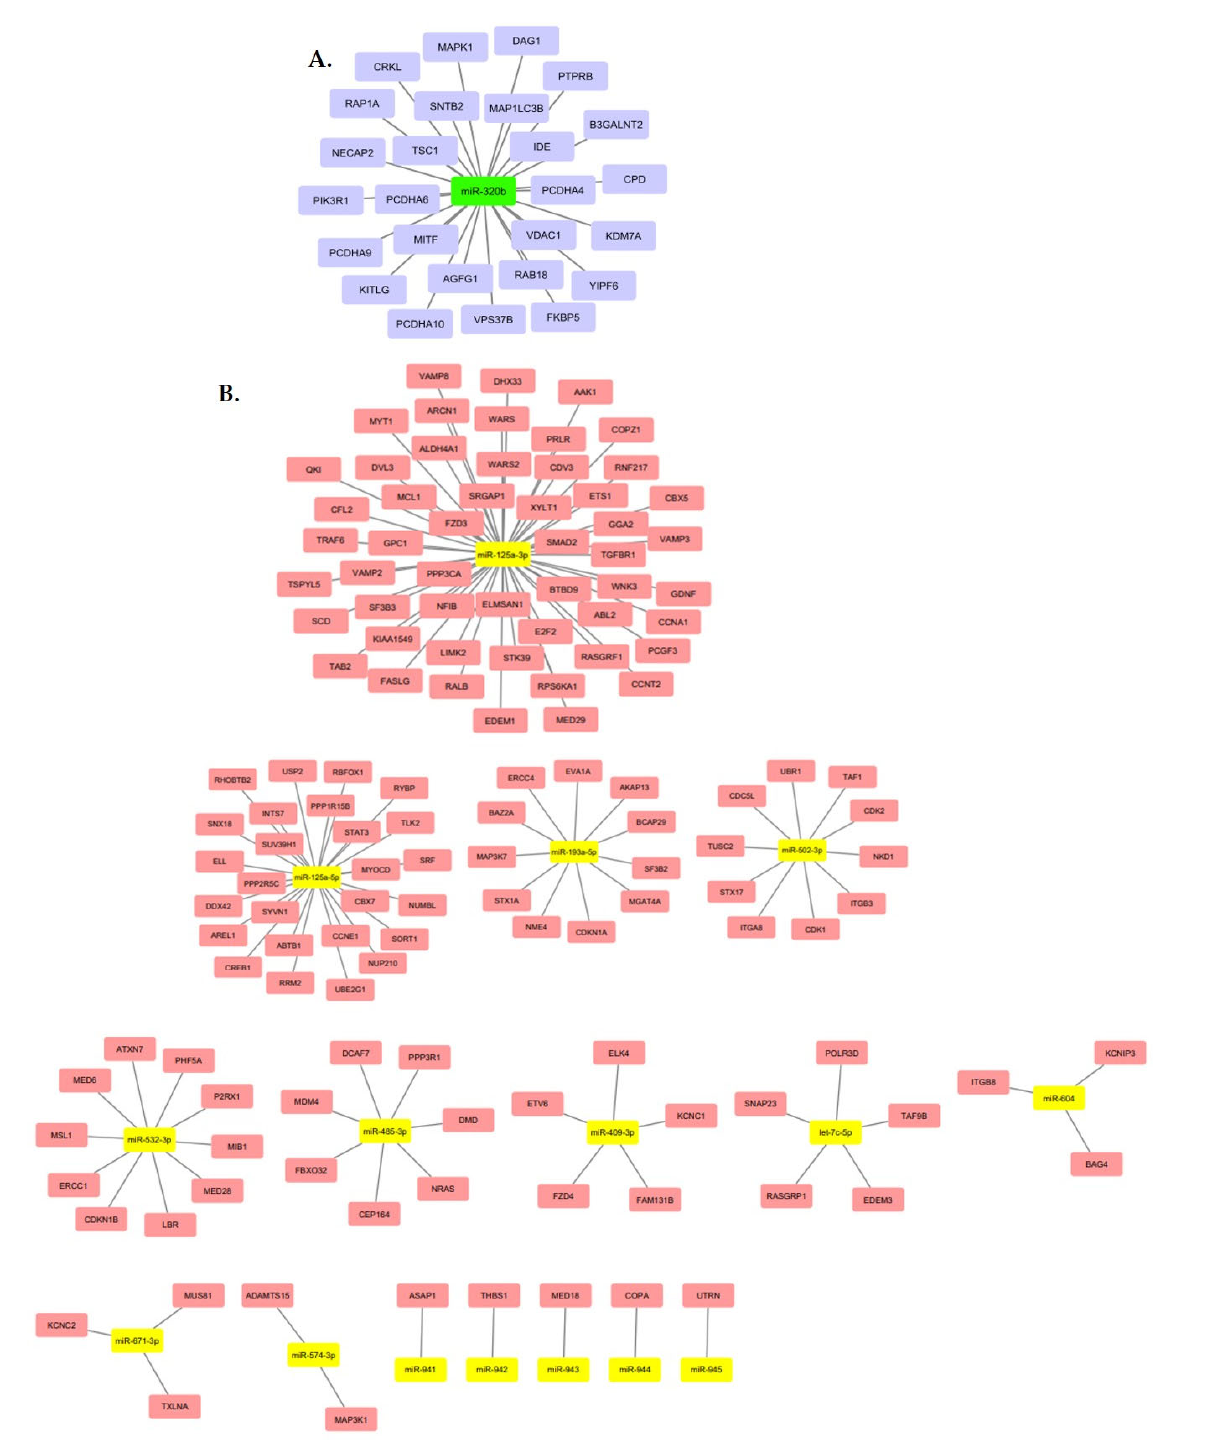
Figure 4. Main upregulated miRNA target genes ( A ). Main downregulated miRNA target genes ( B ).